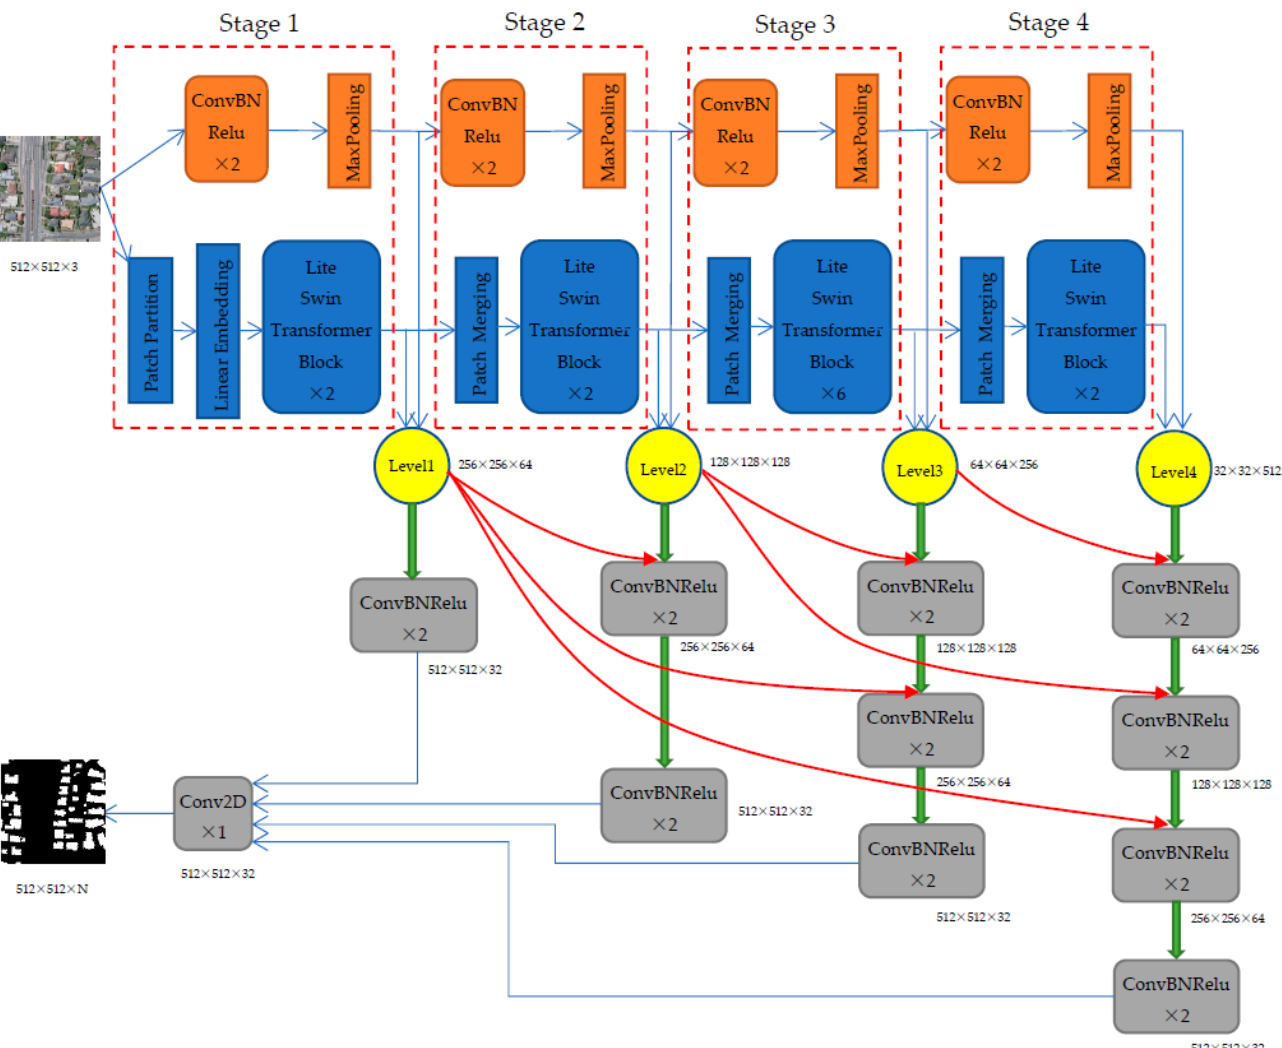
Figure 1. Architecture of the LiteST-Net network model. The orange part is the convolution module, the blue part is the Lite Swin transformer module, and the yellow part shows the extracted features of different levels. The gray part is the decoding module, in which the thick green down arrow is the transpose convolution, and the red curve is the addition of features. The number in the lower right corner of blocks shows the size and channels of the